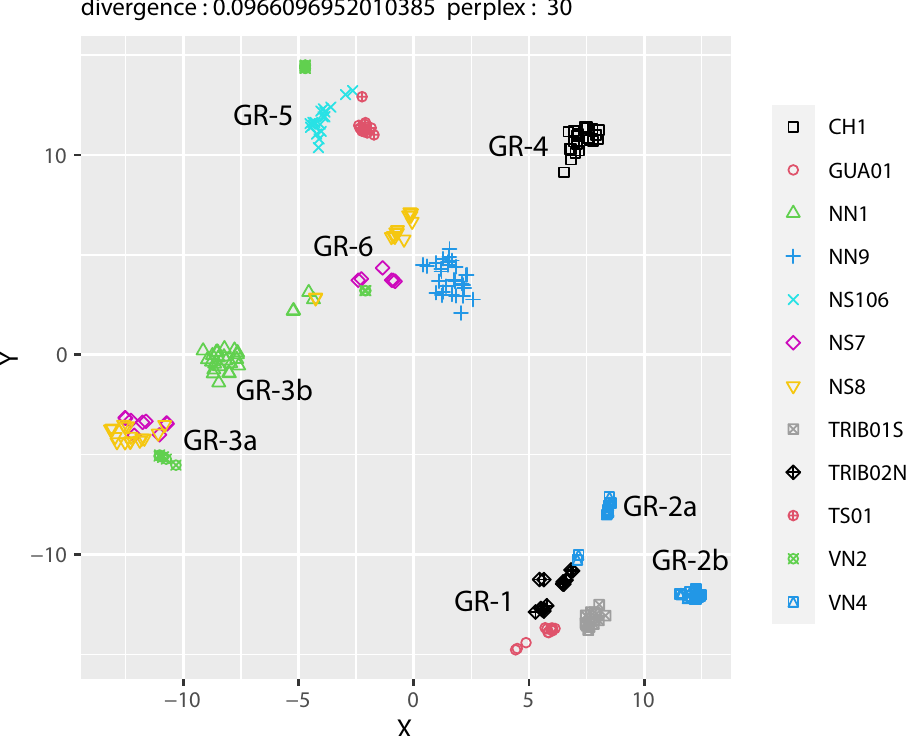
Fig 16. t-SNE on the SI trace element composition (Xij) of all